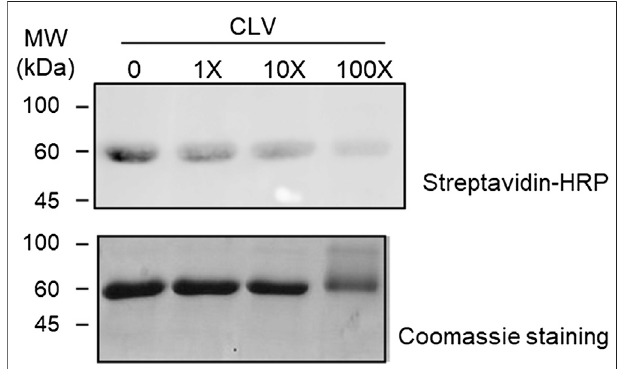
FIGURE 4 | Competition assay between clavulanic acid (CLV) and CLV- tetraethylenglycol-Biotin (CLV-TEG-B). Human serum albumin (HSA) was preincubated with increasing concentrations of CLV (80, 800 and 8,000 μ M) for 16 h at 37 ° C and then with a fi xed concentration of CLV-TEG-B (80 μ M) for 2 h at 37 ° C. Resulting adducts were analyzed by SDS-PAGE and CLV-TEG-B modi fi cation was detected by blot with streptavidin-HRP and ECLdetection (toppanel) .TotalproteinwasdetectedbyCoomassiestaining (bottom panel) .